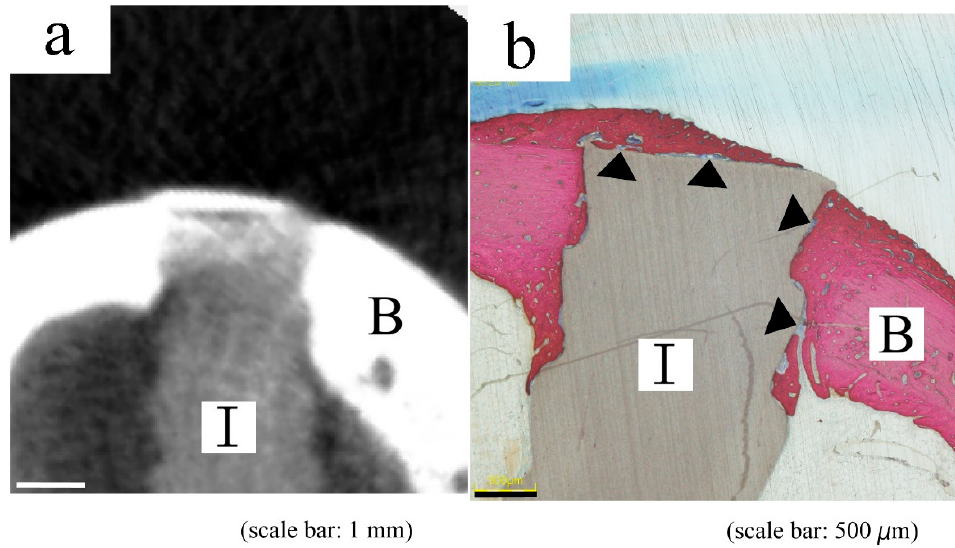
Figure 6. Typical micro-CT ( a ) and histological ( b ) images of same pin with 2.0 mm diameter at 12 weeks. Both images indicate incomplete bone bridging. B, bone; I, HA-PLLA threaded pin.